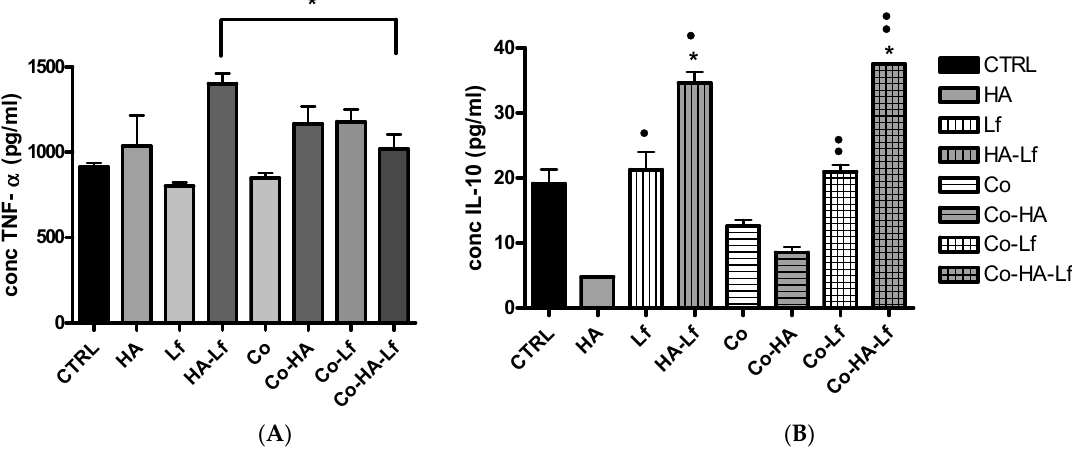
Figure 6. Secreted levels of tumor necrosis factor alpha (TNF- α ) ( A ) and interleukin 10 (IL-10) cytokines ( B ) normalized to cell activity in lipopolysaccharide (LPS) treated condition. Data are presented as mean values ± SD, and significance was determined at * p < 0.05 vs. CTRL, • p < 0.05 vs. HA •• p < 0.05 vs. Co-HA. HA: hydroxyapatite; Lf: